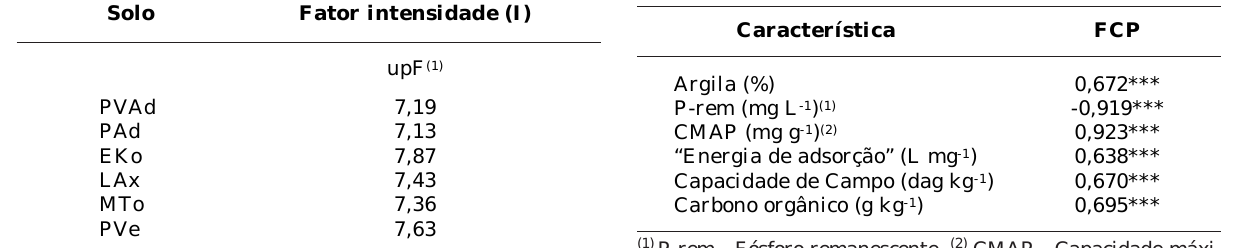
Quadro 4. Fator intensidade, em potencial de fosfato (0,5 pCa + pH